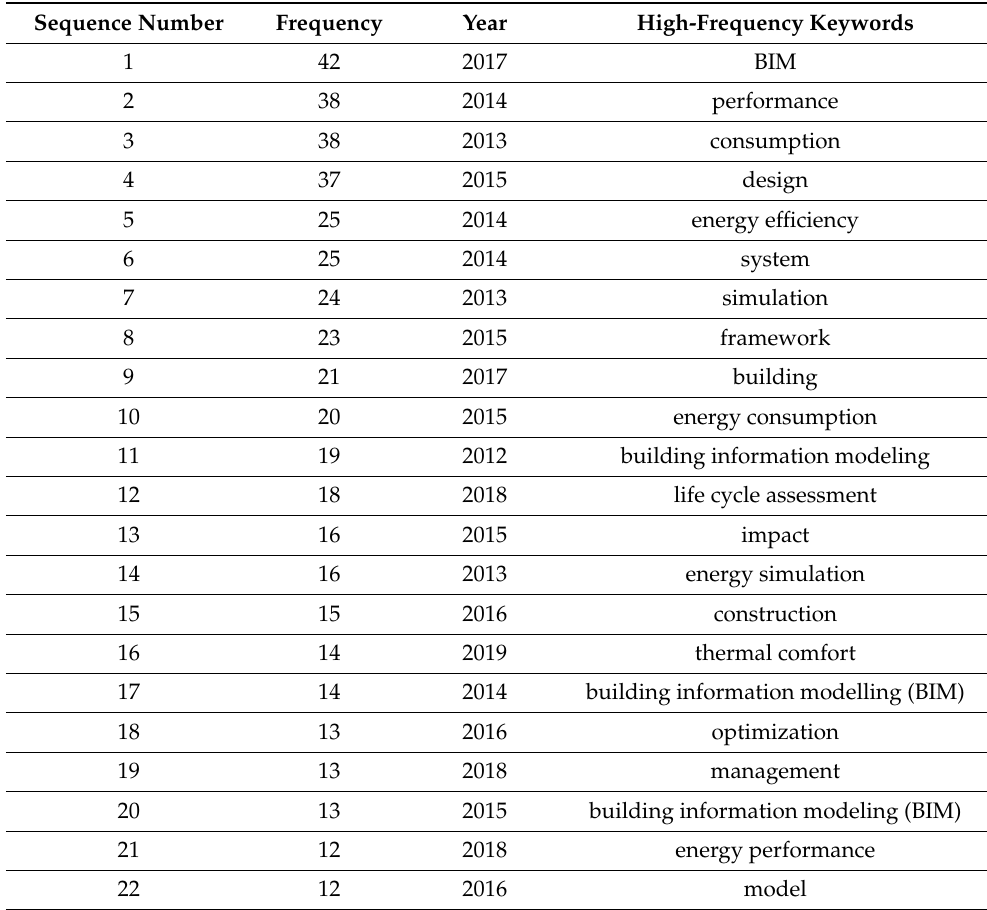
Table 6. High-frequency keywords (frequency >